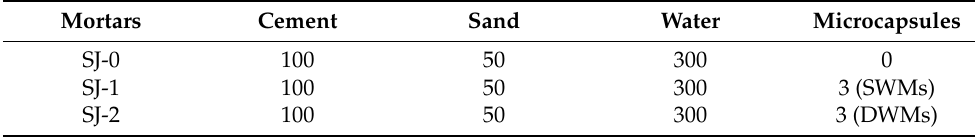
Table 2. Mix designs of the mortars by the mass ratio. Mortars Cement Sand Water Microcapsules SJ-0 100 50 300 0 SJ-1 100 50 300 3 (SWMs) SJ-2 100 50 300 3